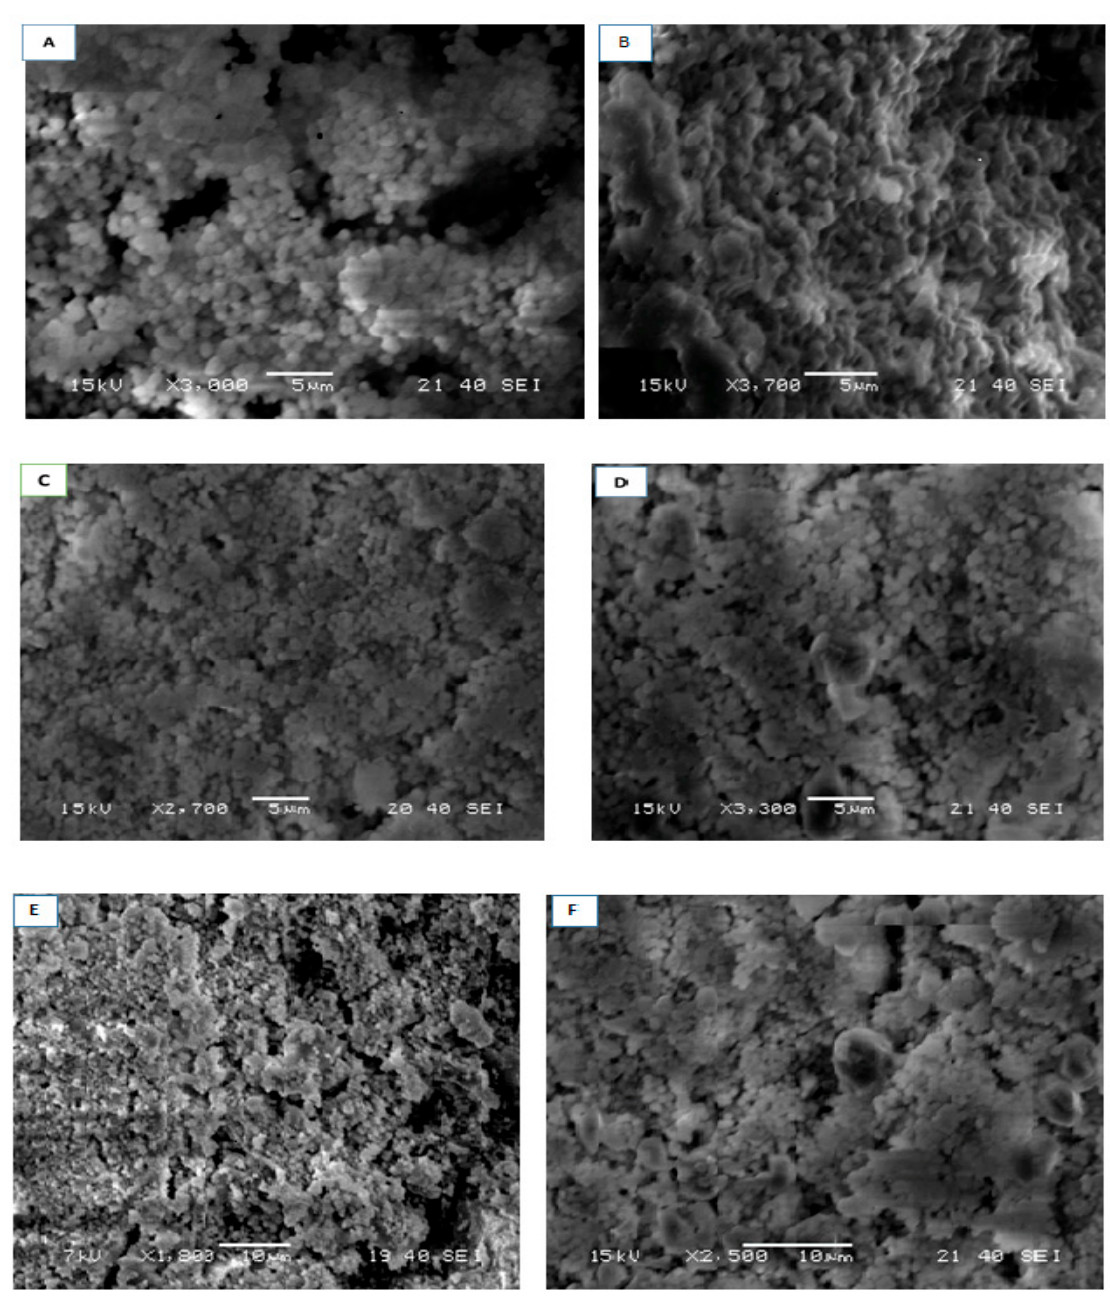
Figure 4. SEM micrographs of untreated, NS, and NS plus β -lactam antibiotics treated methicillin-resistant S. aureus isolates. ( A ) Control methicillin-resistant Staphylococcus aureus (MRSA 4) without any treatment, showing clusters of bacteria. ( B ) MRSA 4 treatment with 5.0 µ g/mL Nigella sativa (NS), displaying surface alterations and destruction. ( C ) SEM of MRSA 4 treated with a combination of 5.0 µ g/mL NS and oxacillin. ( D ) Augmentin combination with the same concentration of NS, showing surface destruction of S. aureus . ( E ) MRSA 5 at 2700 × magnification showing 7.5 µ g/mL NS treatment in combination with augmentin. ( F ) Combination treatment with cefuroxime and 7.5 µg/mL NS at 1800× showing MRSA 5 bacteria cluster surface destruction.